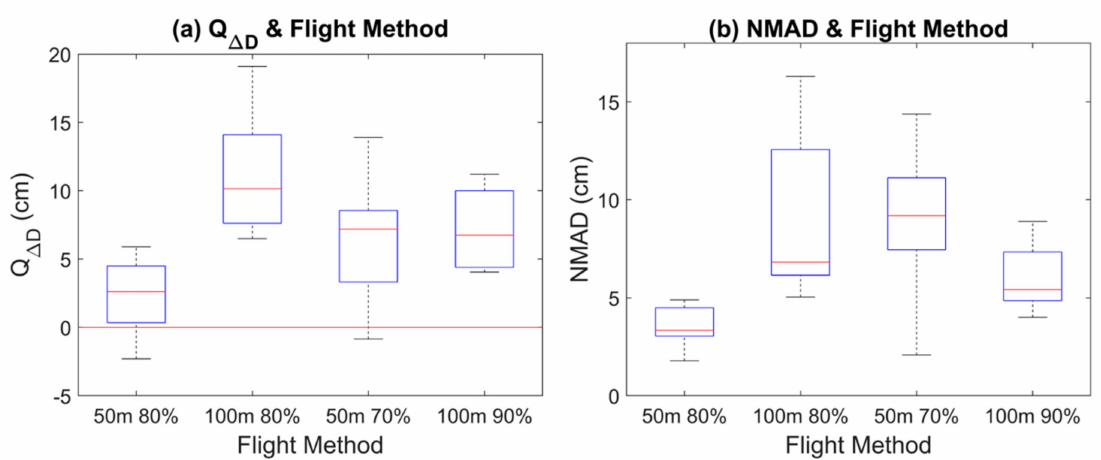
Figure 8. Box plot of ( a ) Median of residuals and ( b ) NMAD of the photogrammetry result varying with different UAV flight altitudes and photograph overlap.